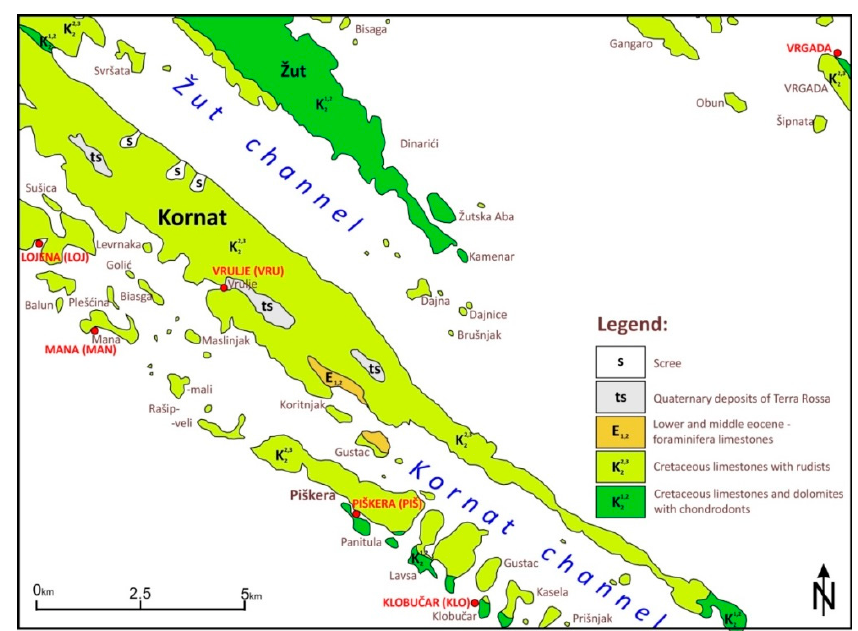
Figure 1. A map showing the sampling locations, exerted from a geological map of SFRY [16].